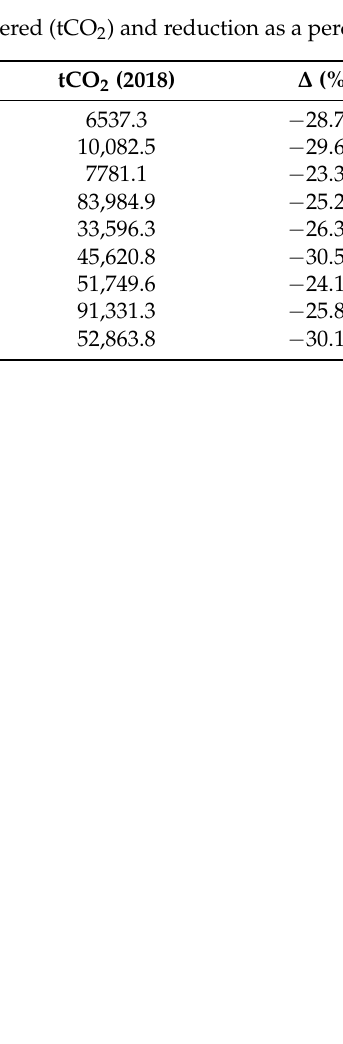
Figure 6. Comparison of per capita emissions between 2005 and 2018. Table 7. Overall emissions for each municipality considered (tCO 2 ) and reduction as a